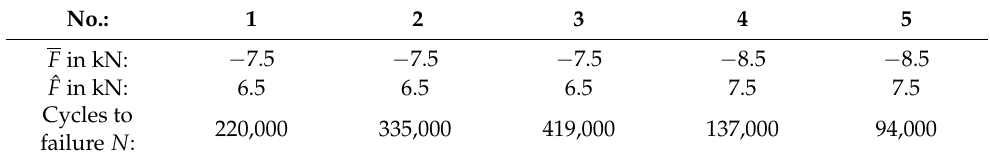
Table 2. Fatigue results in the compression range for filled EPDM rubber (force-controlled